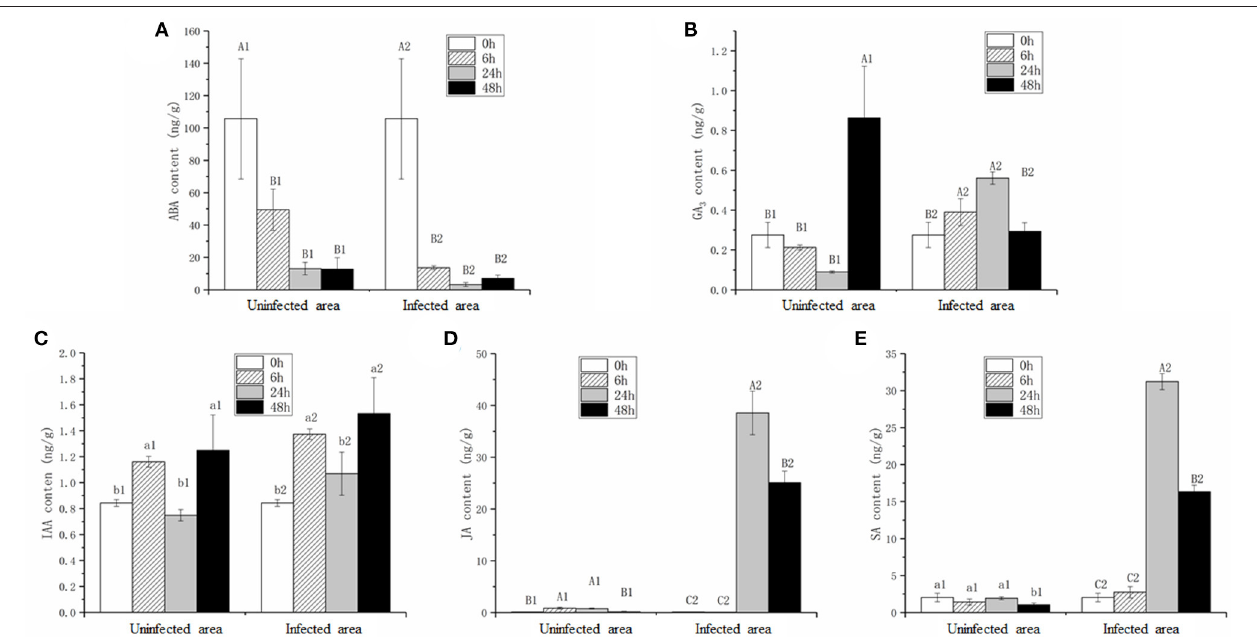
FIGURE 5 | Contents of abscisic acid (ABA) (A) , gibberellic acid (GA3) (B) , indole-3-acetic acid (IAA) (C) , JA (D) , and SA (E) in infected (infected area) and uninfected leaves (uninfected area). Values are the mean ± SD of three biological replicates per treatment. Different letters above each column indicate a significant difference (Capital letters: p < 0.01; others: p < 0.05; n =